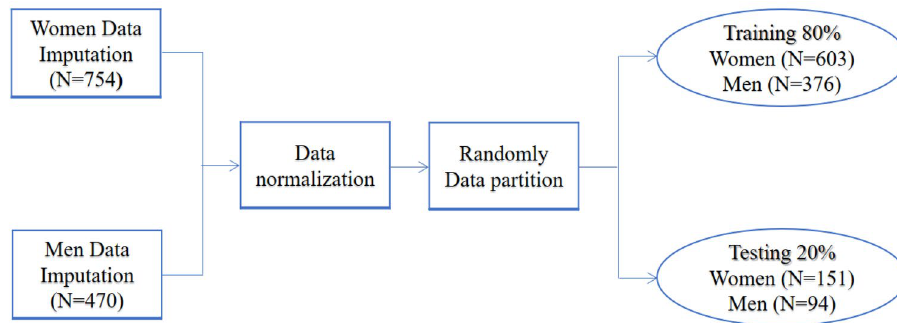
Figure 1. Data processing.